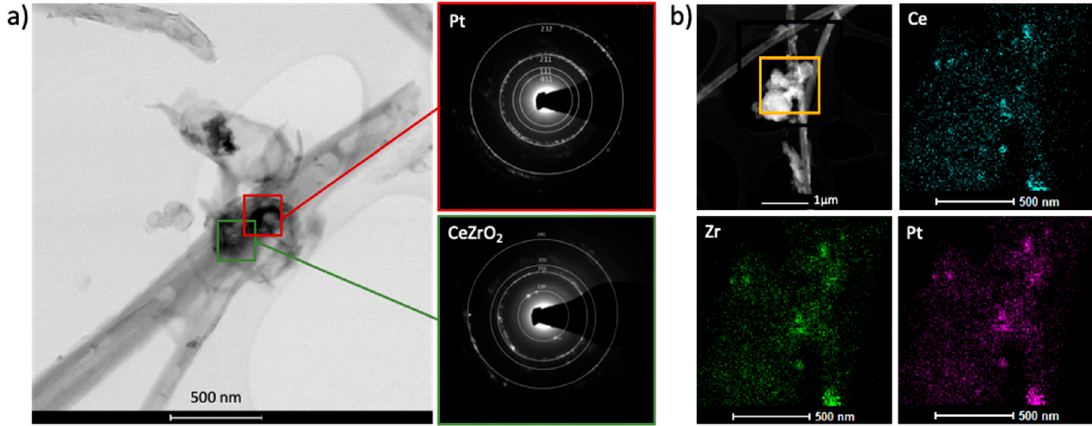
Figure 3. Bright field TEM with SAED ( a ) and elemental mapping for C, Ce, Zr and Ni ( b ) for Ni-CZ/CFF.